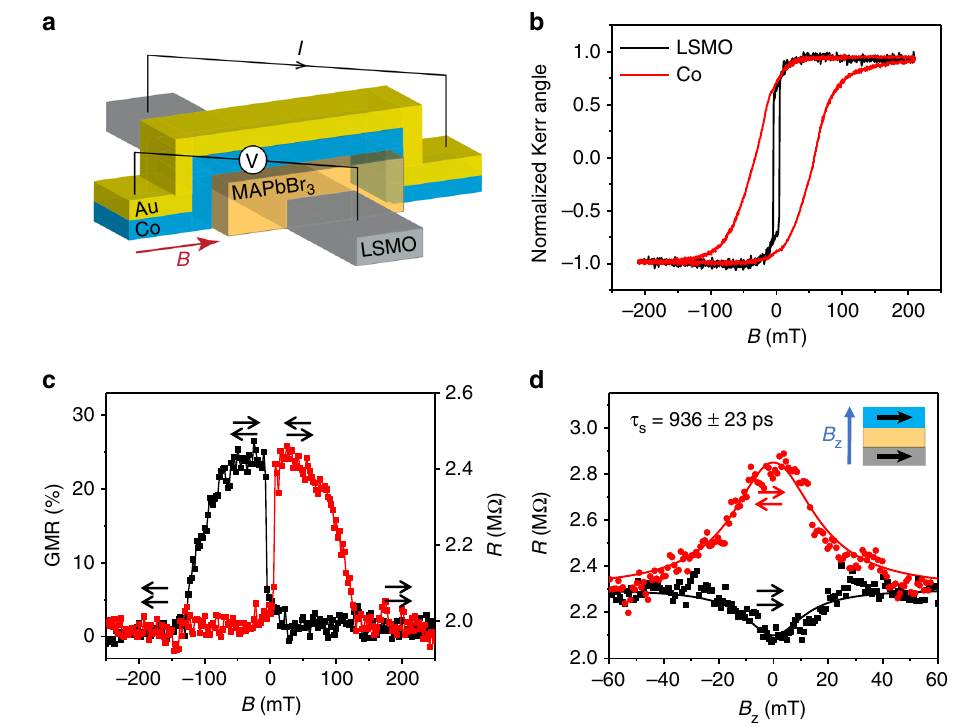
Fig. 4 Giant magnetoresistance (GMR) and Hanle effect in MAPbBr 3 -based spin valve. a Schematic of a LSMO/MAPbBr 3 /Co spin valve device structure. b MOKE( B ) response of the LSMO and Co ferromagnetic electrodes as measured in-situ in the SV device at 10 K. c GMR( B ) response of the spin-valve measured at 10 K and applied bias voltage, V = 0.1 V. The obtained maximum GMR value (GMR max ) is 25%. The red and black lines represent magnetic fi eld sweep up and down, respectively. The arrows show the mutual magnetization direction of the two FM electrodes. d Hanle effect of the GMR measured when a magnetic fi eld, B z perpendicular to the FM electrodes is applied, at both parallel and antiparallel magnetization con fi gurations. The solid lines are fi ts using Eq. (3), from which a spin lifetime τ s = 936 ± 23 ps is